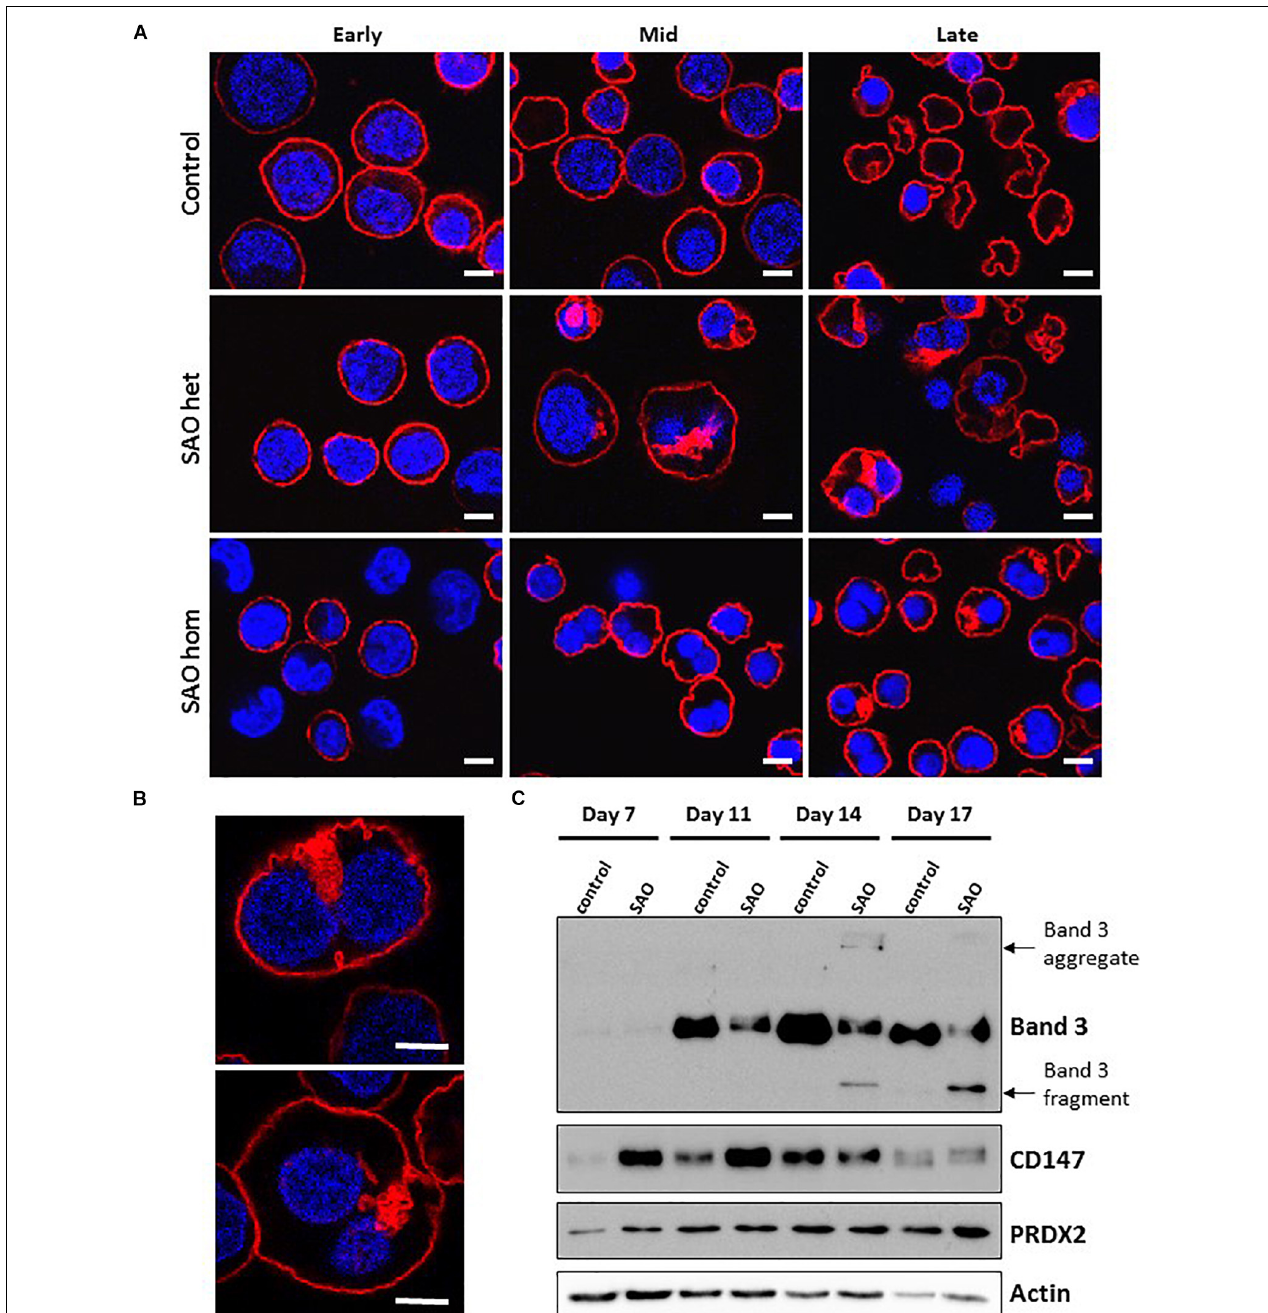
FIGURE 6 | Expression of SAO band 3 throughout erythropoiesis. Control, heterozygous (father of proband) and homozygous SAO CD34 + cells were cultured for 21 days and their band 3 expression was monitored by the use of monoclonal anti-band 3 antibody after fixation and permeabilization. Confocal microscope images are shown from 3 different time-points: Early (day 10), Mid (day 14) and Late (day 21). (A) Comparison of control, heterozygous and homozygous SAO cells using BRAC17 (red) and DAPI (blue). Early homozygous SAO erythroblasts express very little band 3 probably because SAO band 3 is mis-folded and has problems trafficking to the red cell membrane. The difference in size and morphology of cells, especially notable in heterozygous SAO cells mid-culture is due to the formation of the large aberrantly-shaped SAO cells that eventually become SAO red cells. Scale bars represent 5 µ m. (B) Higher magnification images of day 17 heterozygous SAO cells exhibiting internal clusters of band 3 vesicles. Staining shows Band 3 (BRAC17; red) and nuclei (DAPI; blue). Images are representative of at least 5 different fields from one experiment. Scale bars represent 5 µ m. (C) Immunoblot of cultured homozygous SAO and control cell lysates probed with anti-band 3 (BRIC170); anti-CD147 (rabbit monoclonal antibody; ab108308); anti-PRDX2 (ab109367) and loading control anti-actin (ab6276).